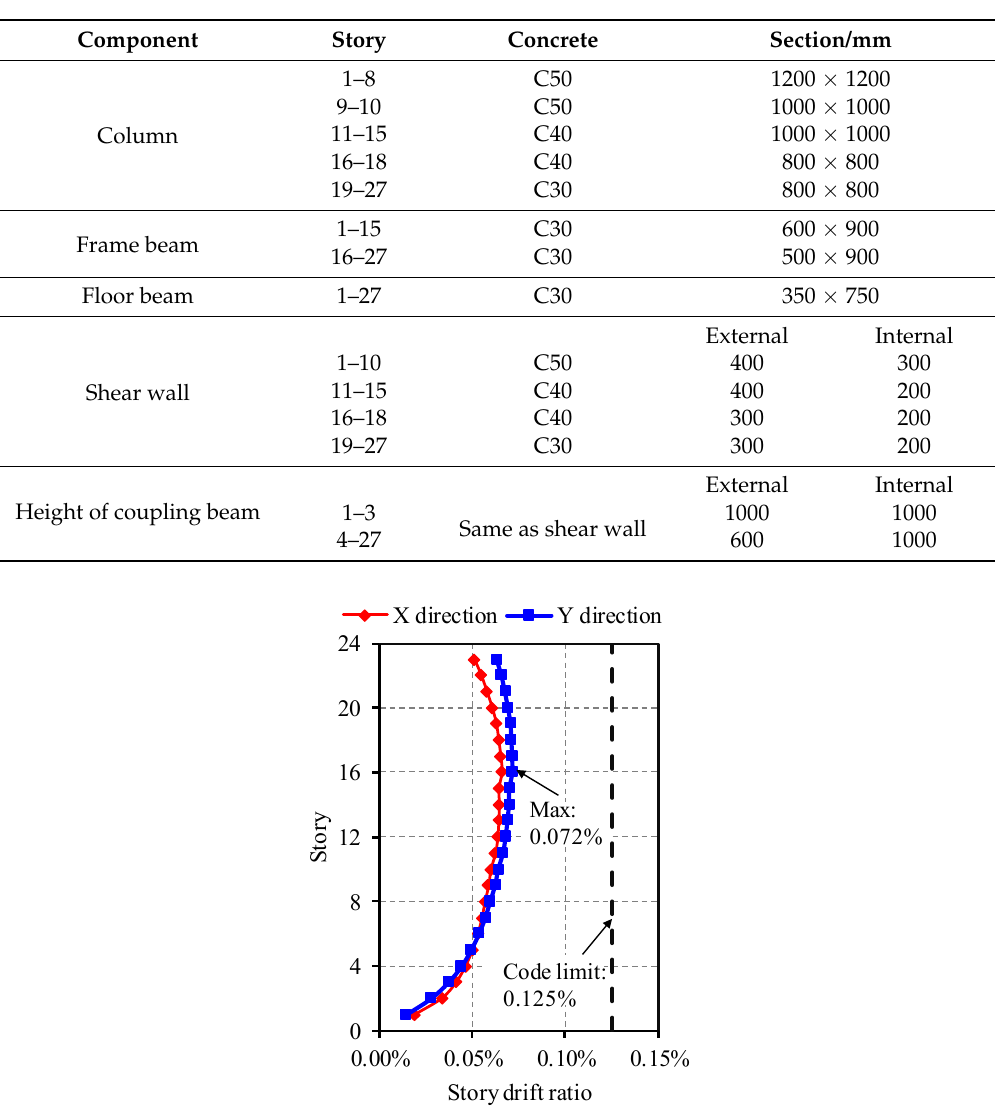
Table 4. Concrete strength and section size of components.